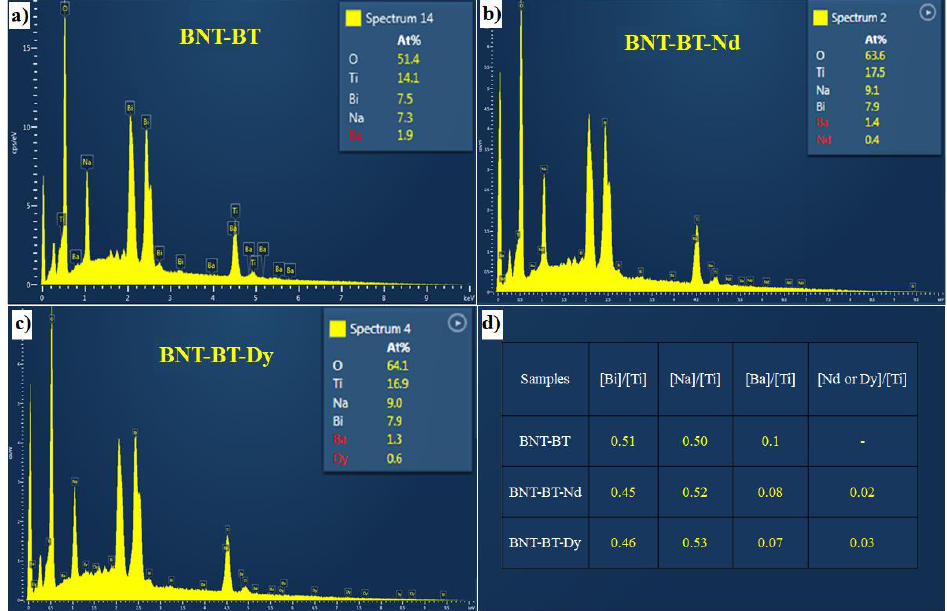
Figure 2. EDX spectra with the atomic percentage of ( a ) BNT-BT, ( b ) BNT-BT-Nd, ( c ) BNT-BT-Dy, and ( d ) table of atomic ratios.